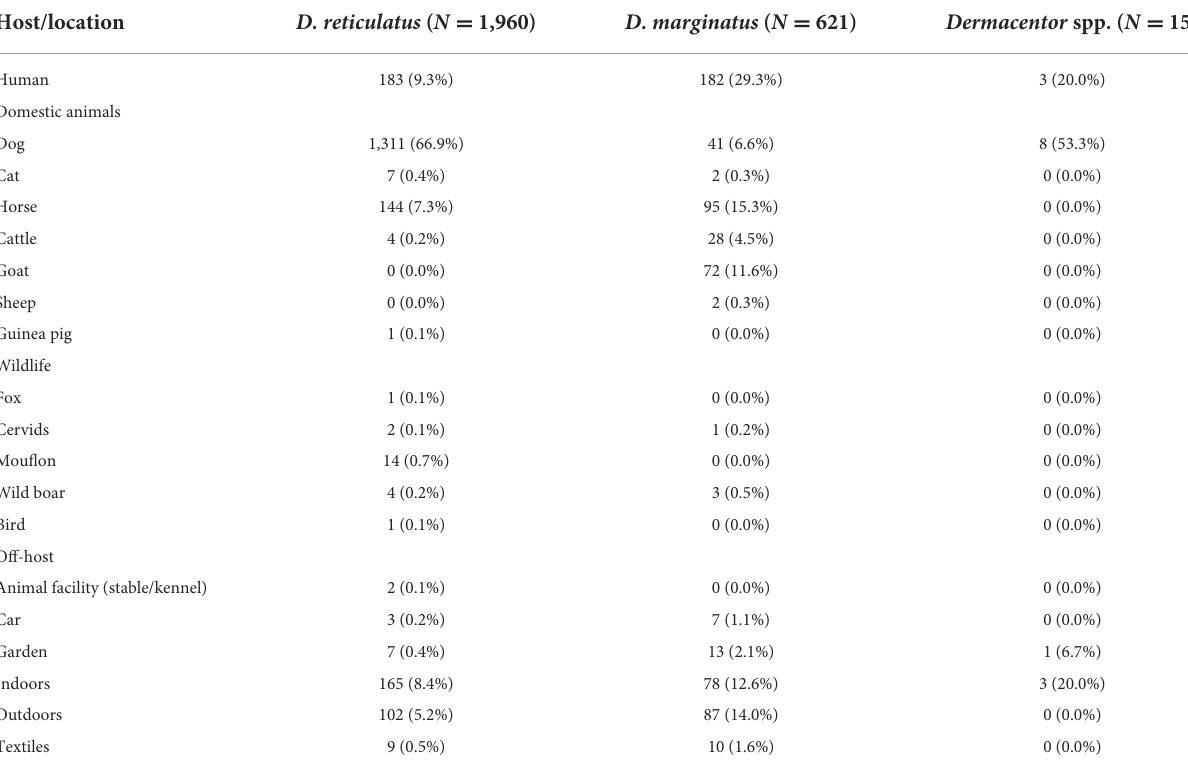
TABLE 3 Host association or location of collection, respectively, for the subset of Dermacentor ticks for which this information was available.